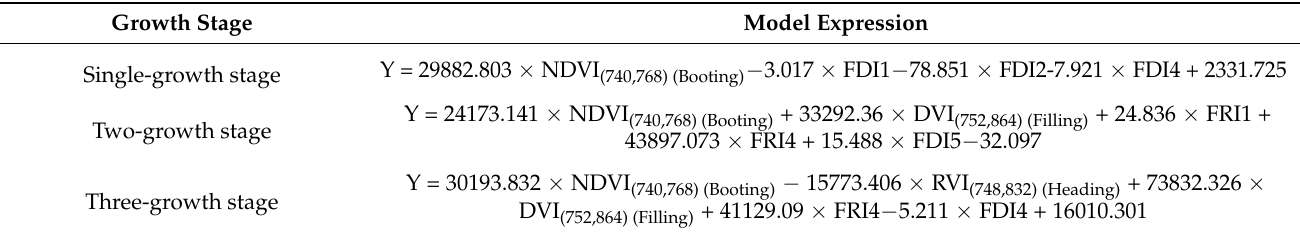
Table 5. The expressions for the optimization model with single, two and three growth stages involved. Growth Stage Model Expression Single-growth